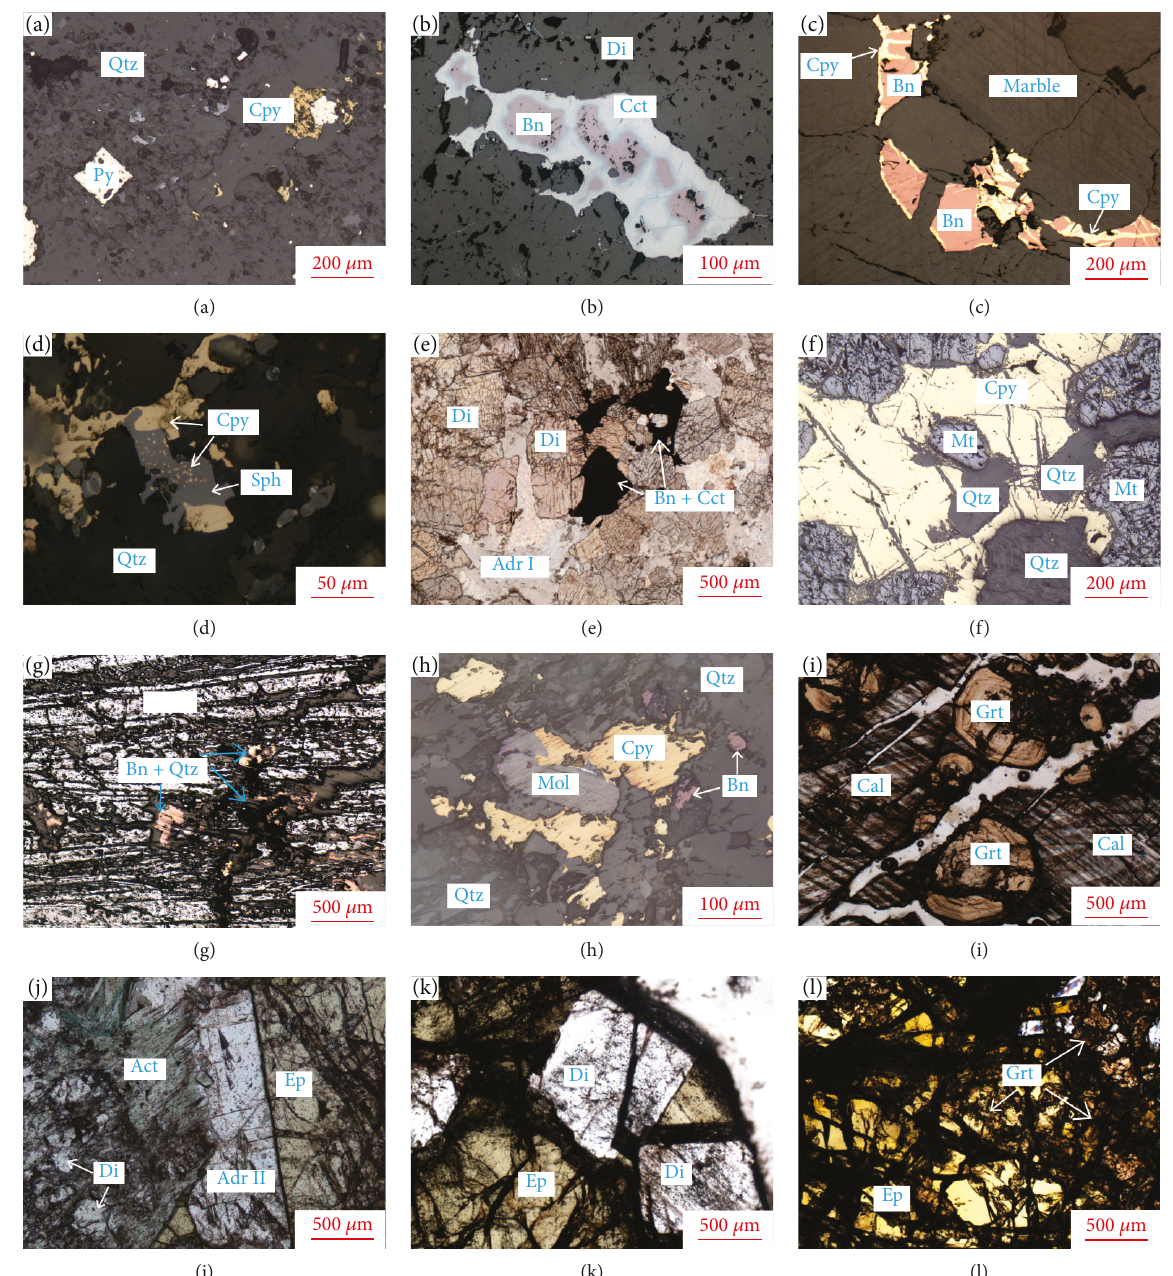
Figure 6: Photomicrographs of representative samples under transmitted plane polarized light (e, i – l) and re fl ected plane polarized light (a – d, f – h) illustrating mineral assemblages, textures of ores, and alterations in the Fuzishan Cu-Mo deposit. (a) Euhedral pyrite and anhedral chalcopyrite that replace along the margin of pyrite in cryptocrystalline to fi ne-grained quartz vein. (b) Rosy bornite occurring as relicts replaced by grey-white chalcocite in diopside skarn. (c) Chalcopyrite decomposed along the margin or within bornite as irregular bands in marble. (d) Chalcopyrite decomposed in the form of emulsion texture in sphalerite in quartz vein. (e) Bornite, chalcocite, and coexisting late anhydrite in the interstitial space of diopside skarn. (f) Chalcopyrite together with quartz replacing magnetite. (g) Bornite+quartz veinlet crosscutting hematite. (h) Plate-like molybdenite superimposed by subsequent chalcopyrite and bornite in quartz vein. (i) Cracked euhedral garnet replaced by quartz-sul fi de stage calcite. (j) Actinolite and epidote replacing diopside, eventually crosscut by the late anhydrite of the quartz-sul fi de stage. (k) The cubic diopside in the prograde skarn stage replaced by epidote of the retrograde skarn stage. (l) Garnet nearly replaced by epidote and retaining euhedral crystal morphology. Py: pyrite; Cpy: chalcopyrite; Bn: bornite; Cct: chalcocite; Mol: molybdenite; Sph: sphalerite; Mt: magnetite; Hem: hematite; Grt: garnet; Di: diopside; Ep: epidote; Kfs: k-feldspar; Adr I: